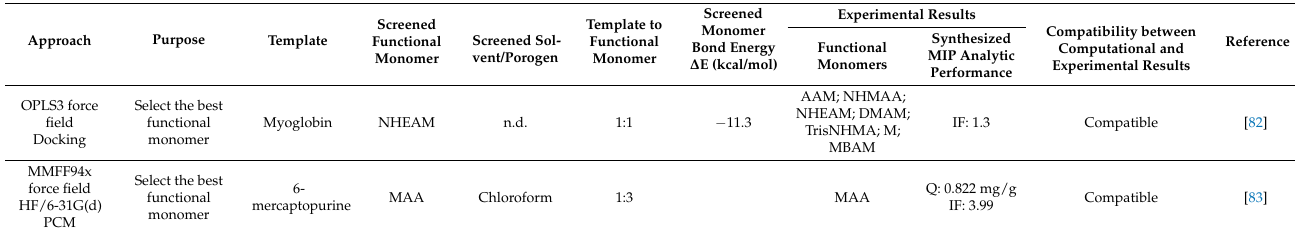
Table 8. Molecularly imprinter polymer (MIP) design using molecular mechanics.